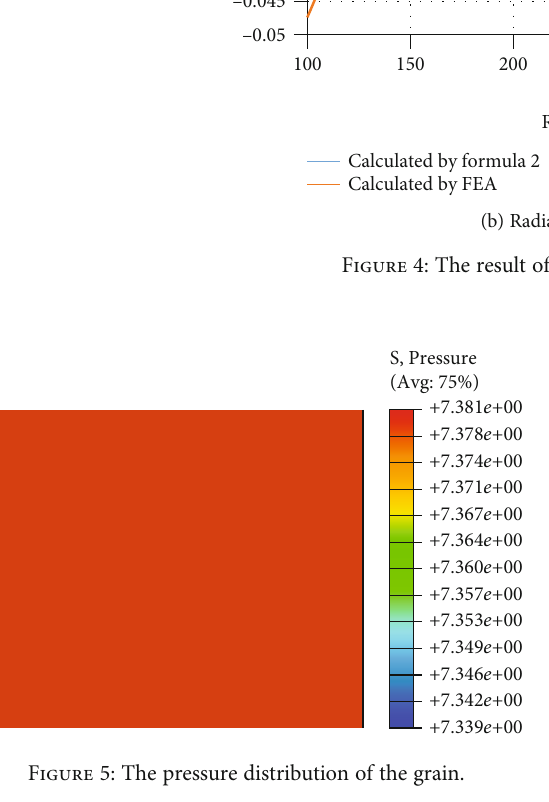
Radial strain curve